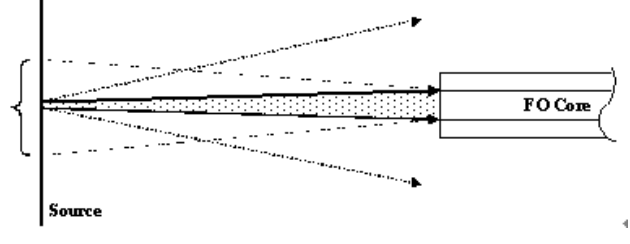
Figure 5. Diagram showing the part of the source (heavy vertical line) that is within the acceptance angle of a nearby fiber optic (indicated by the bracket), and the solid angle of light from one part of that region, which is intercepted by the core of a fiber